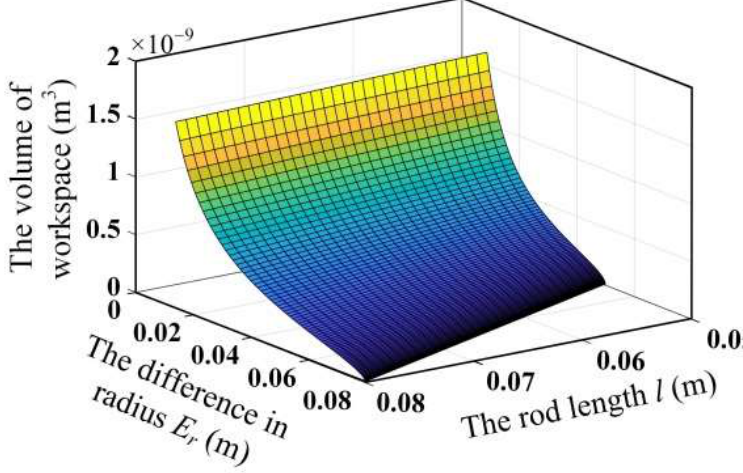
Figure 3. Relationship between workspace volume and scale parameters.